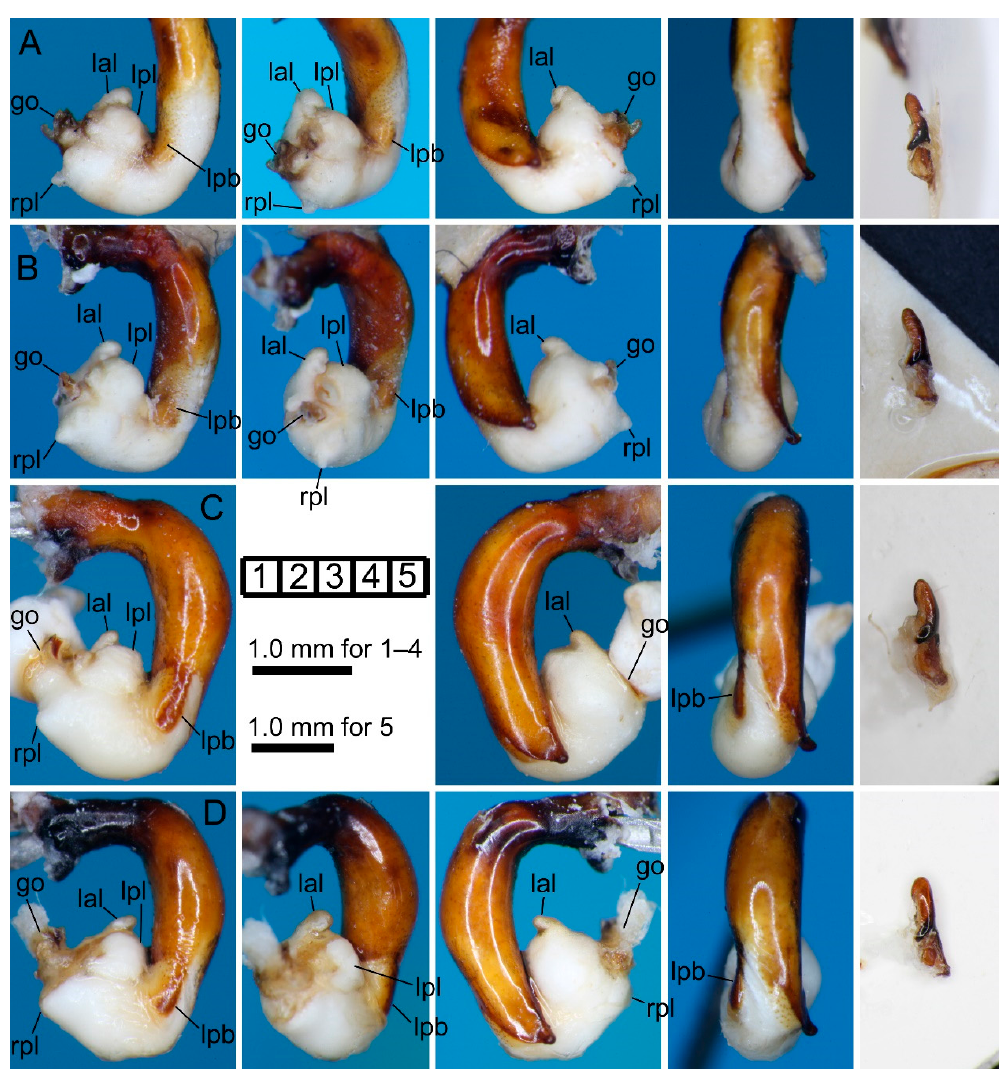
Figure 7. Left lateral ( 1 ), ventral ( 2 ), right lateral ( 3 ), and dorsal ( 4 ) views of aedeagus (part) with the everted endophallus and left lateral view ( 5 ) of right paramere of the macrogenys species group; ( A ), ( B ) P. eboshiyamanus male from Yunosawa ( A ) and holotype male from “River Tokorozawa” ( B ), ( C ), ( D ) P. monolineatus sp. n. holotype ( C ) and paratype ( D ) male from